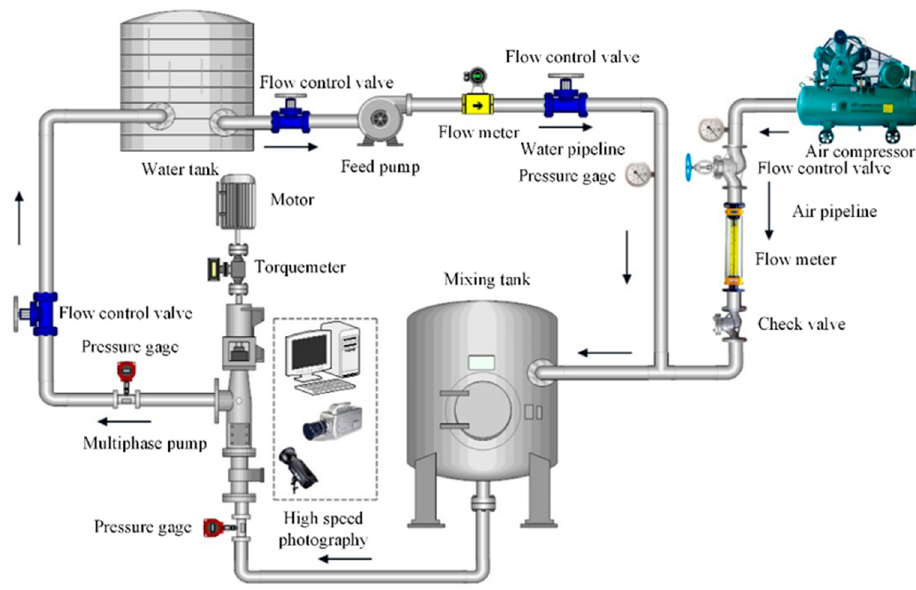
Figure 6. Multiphase pump experimental system.